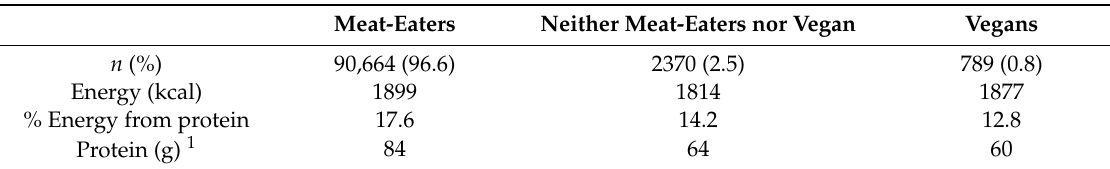
Table 2. Protein intake of vegetarians compared to meat-eaters in the Nutrinet-Sant é Study, based on declarations about being a vegetarian (i.e., not eating meat but eating other animal products) or a vegan (not eating any meat, fish, eggs or dairy). Data from Alles et al.